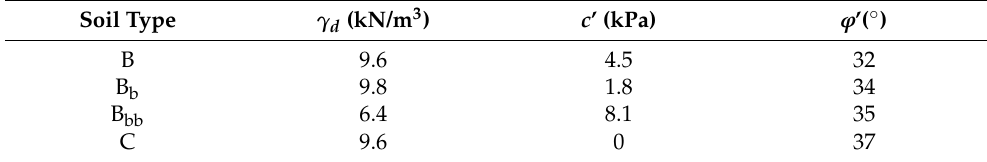
Figure 10. Engineering geological profiles of three slopes. Table 2. Main physical and mechanical properties of the materials of three slopes.